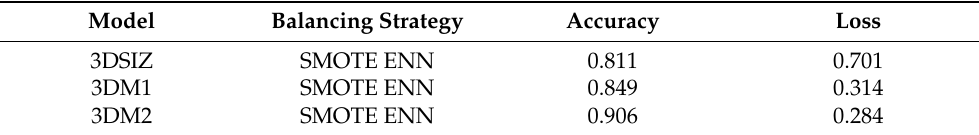
Table 6. Model performance: ACC metric